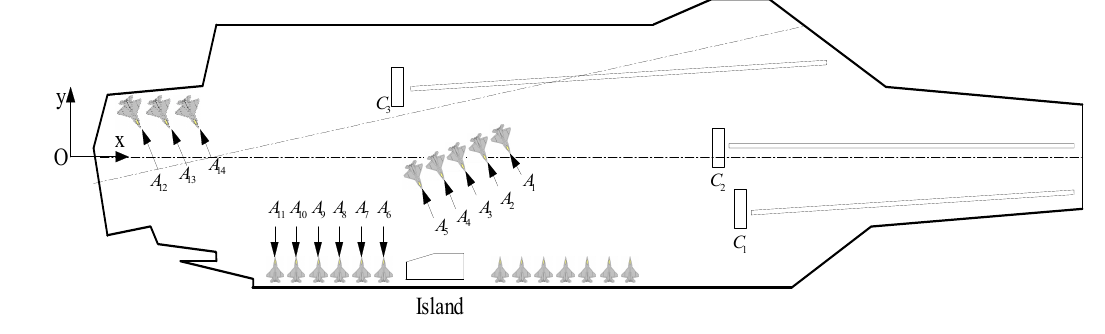
Figure 6. Flow of the path planning algorithm.